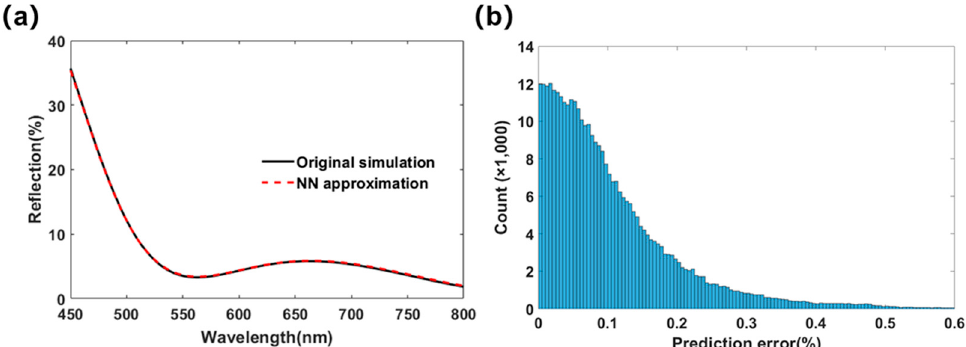
Figure 7. ( a ) The predicted reflection spectrum by NN compared to TMM and ( b ) the error distributions for NN in the five-layer AR case.